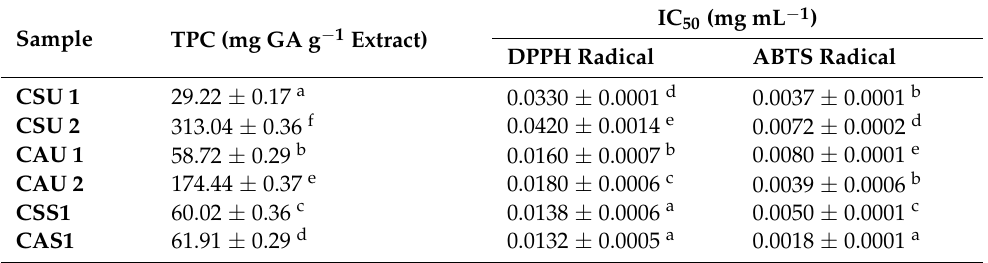
Table 3. Total phenolic content and antioxidant activity of the extracts from Carob Selvatica and Amele leaves. Each measurement was carried out in triplicate and data are expressed as means ( ±